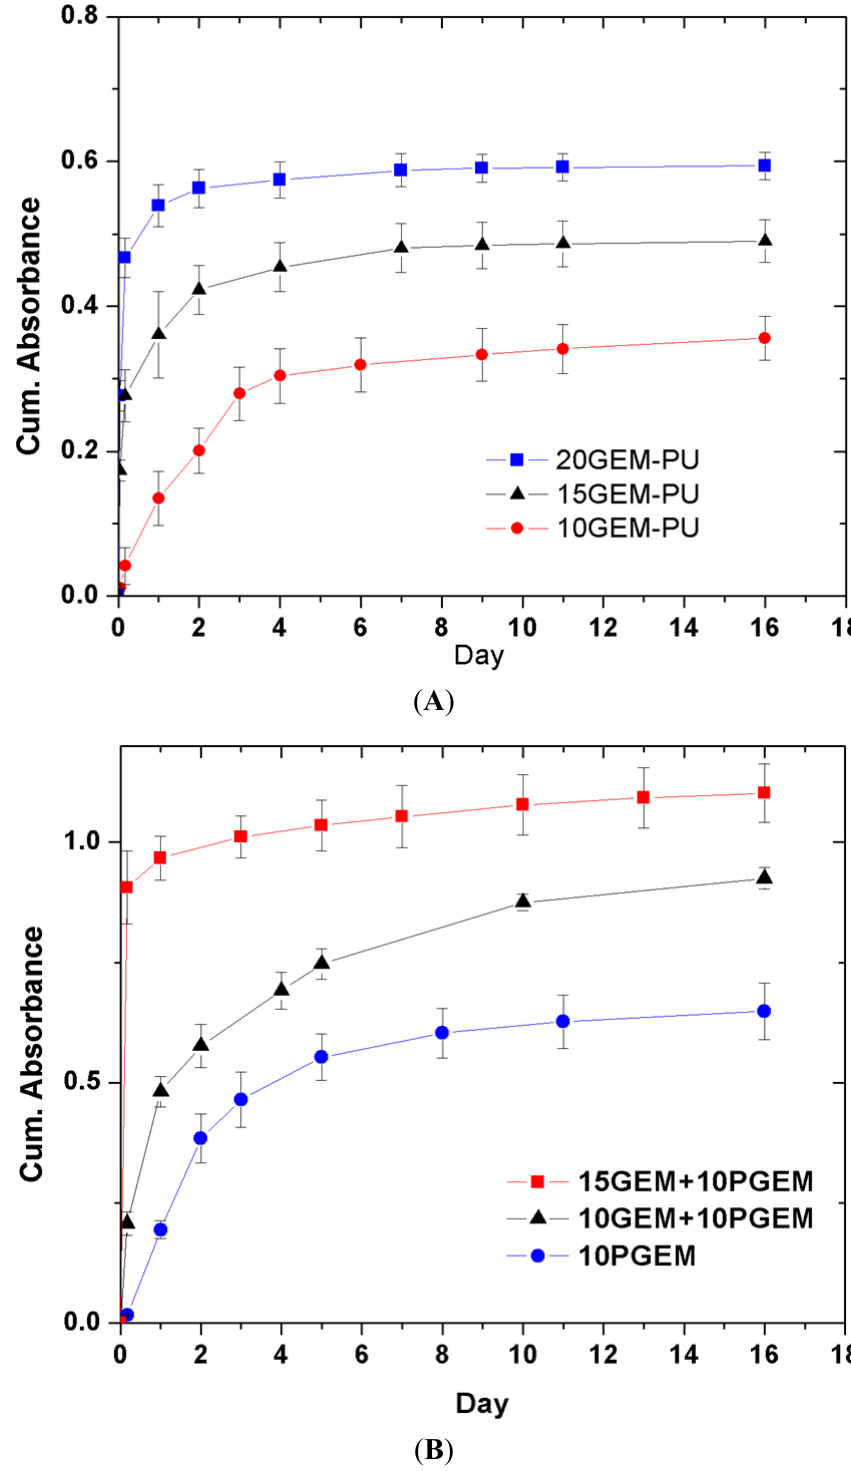
Figure 8. Gemcitabine release behavior from a polyurethane film. Initial burst increases with drug dose when a clinical formulation of gemcitabine (GEM) is used ( A ). The initial burst is negligible for pure gemcitabine (PGEM) but it increases when the clinical form GEM is added ( B ). (Reprinted with permission from [37]. Copyright 2012 Editions de